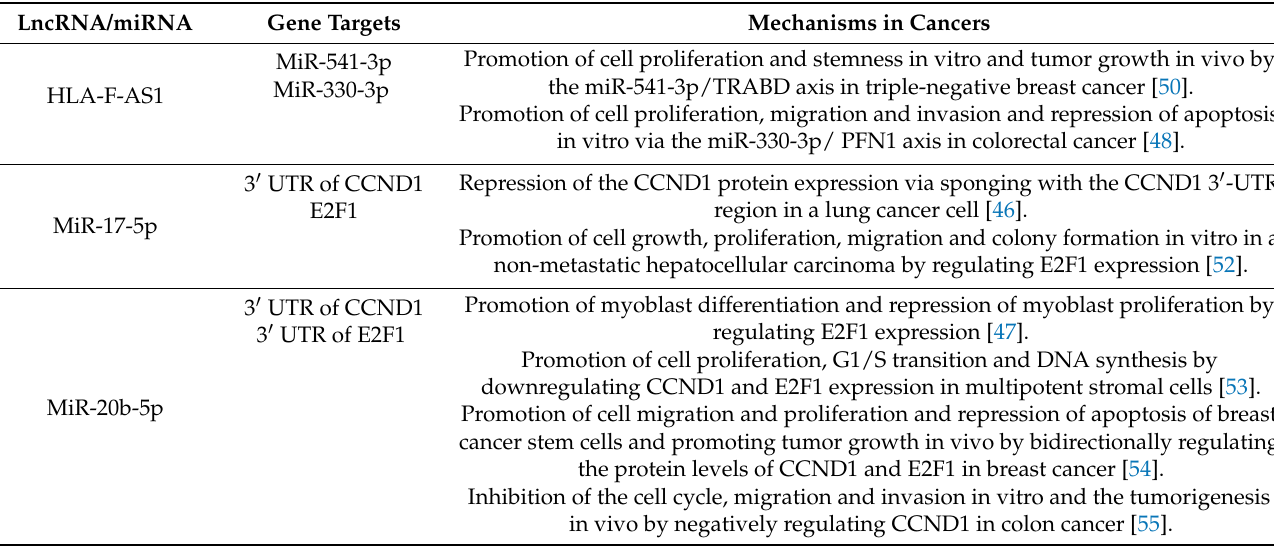
with significant correlations, Table S2: DElncRNA-miRNA pairs of the ceRNA network, Table S3: DEmRNA-miRNA pairs of the ceRNA network, Table S4: Over-expressed and down-expressed lncR- NAs of the ceRNA network, Table S5: Over-expressed and down-expressed mRNAs of the ceRNA network, Table S6: GO enrichment terms of DEmRNAs in the ceRNA network, Table S7: KEGG pathway enrichment of DEmRNAs in the ceRNA network, Table S8: Details of DElncRNA-miRNA pairs of the core ceRNA network, Table S9: DEmRNA-miRNA pairs of the core ceRNA